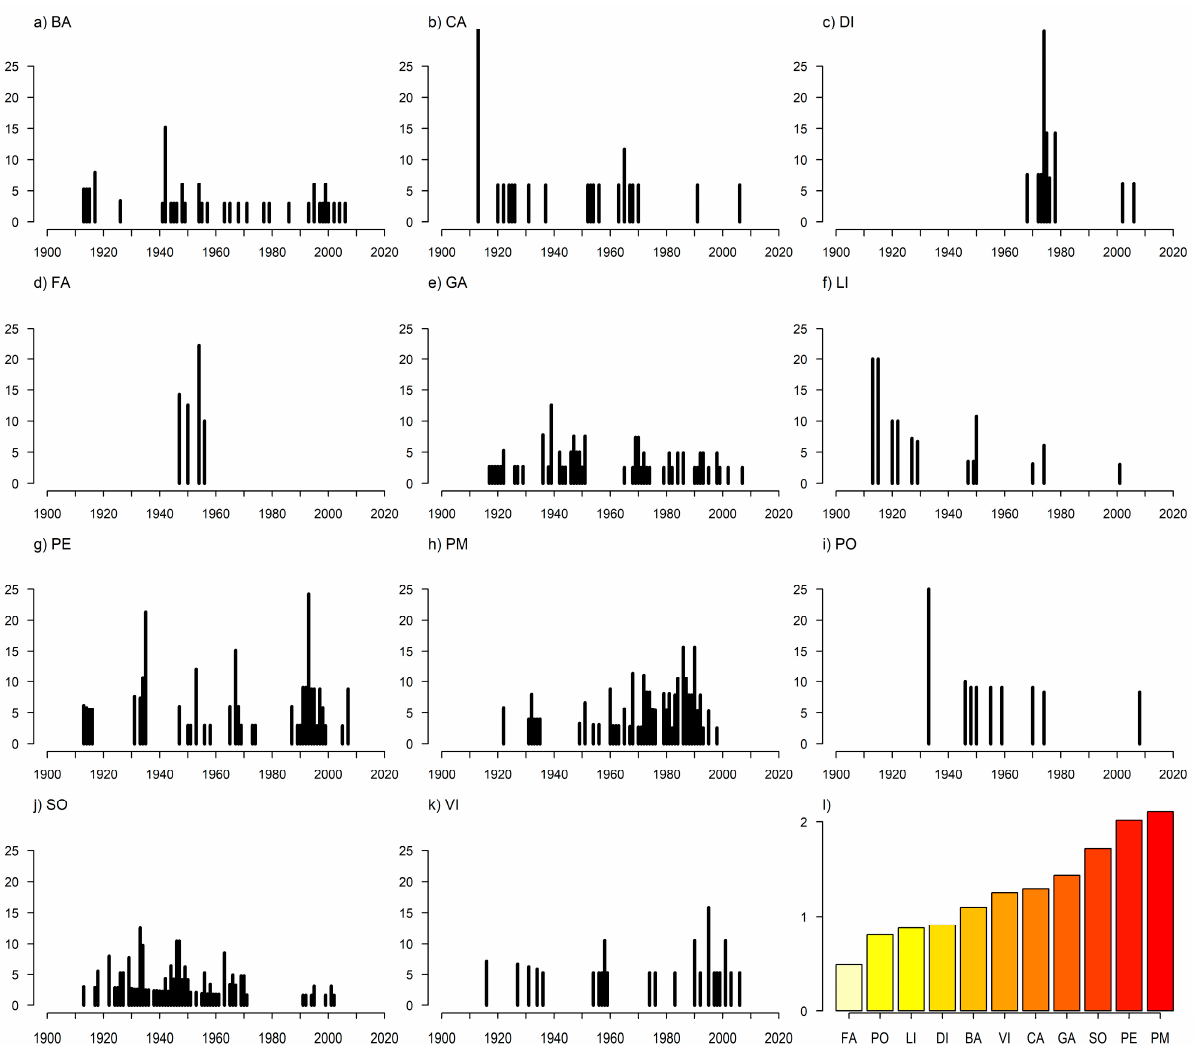
Figure 2. Number of major growth releases per site during the period 1900–2016 ( a – k ) and average number of releases per year in each site ( l ). The colors in the last chart are proportional to the average percentage of releases. See site codes in Table 1.